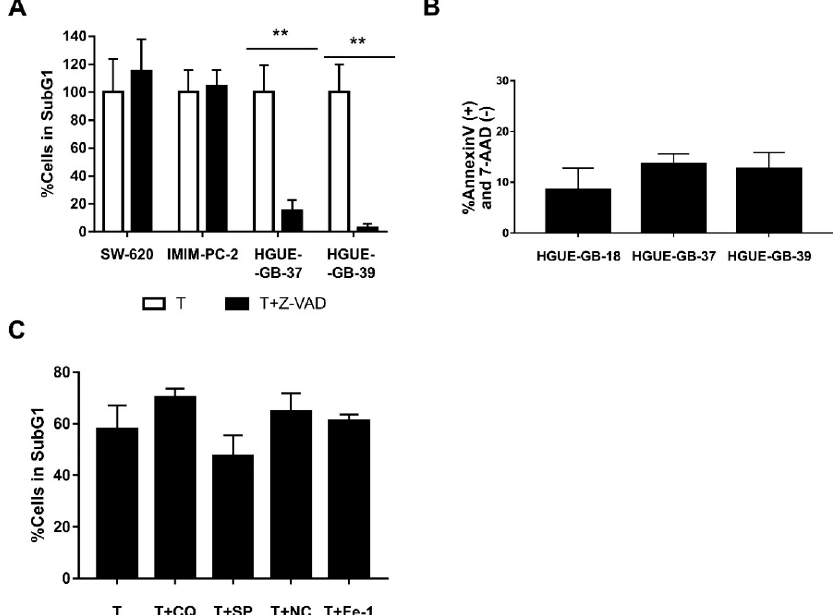
Figure 6. Type of cell death induced by CLytA-DAAO. ( A ) SW-620, IMIM-PC-2, HGUE-GB-37, and HGUE-GB-39 cell lines were treated with 2 U mL − 1 free CLytA-DAAO, and 1 mM D-Ala in the presence or absence of 25 μ M Z-VAD for 24 h and cell cycle distribution was determined by flow cytometry. ( B ) HGUE-GB-18, HGUE-GB-37, and HGUE-GB-39 glioblastoma cell lines were treated with 2 U mL − 1 CLytA-DAAO, and 1 mM D-Ala, for 24 h and apoptotic cell death was determined through Annexin V-PE (+) and 7-AAD ( − ) labeling by flow cytometry. ( C ) IMIM-PC-2 cell line was treated with 2 U mL − 1 CLytA-DAAO, and 1 mM D-Ala in the presence or absence of 10 μ M chloroquine (CQ), 10 μ M spautine-1 (SP), 20 μ M necrostatine-1 (NC), and 10 μ M ferrostatin-1 for 24 h and cell cycle distribution was determined by flow cytometry. Data represent the percentage of cells in sub-G1 phase, normalizing the treatment with CLytA-DAAO as 100% ± SEM with n ≥ 3. ** indicates p < 0.01.